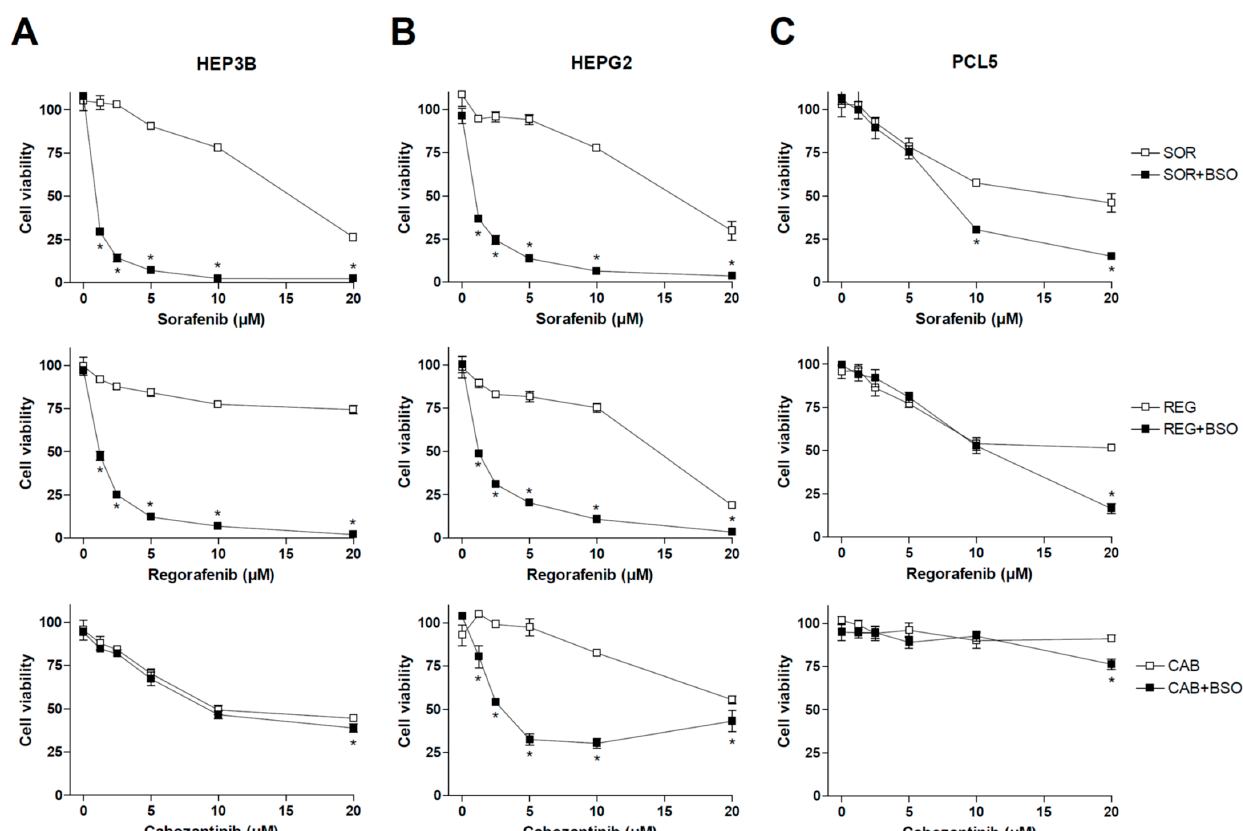
Figure 1. Effect of BSO administration on liver tumor cell lines treated with MKIs. Hep3B (A), HepG2 (B) and PLC5 (C) cells were exposed to increasing doses of sorafenib, regorafenib and cabozantinib for 20 h after incubation with vehicle (PBS) or BSO (1 mM), inhibitor of GSH synthesis, and cell viability quantified by MTT ( n = 3). * p < 0.05 vs. control.